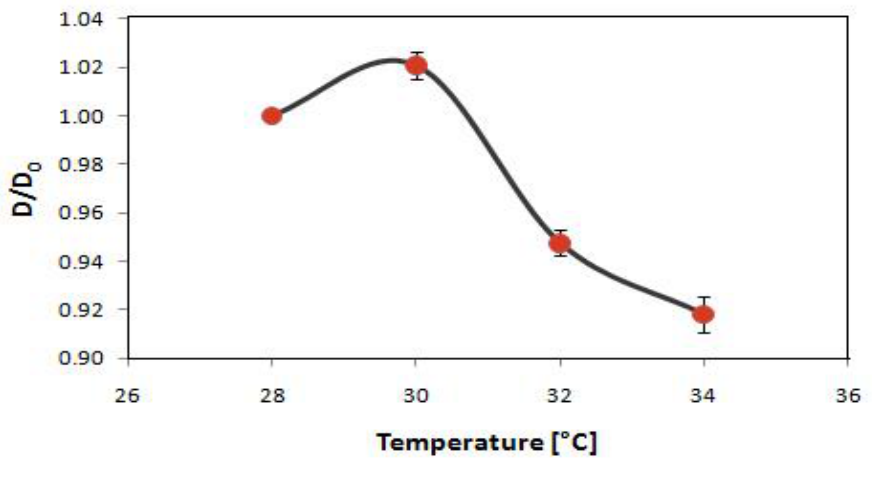
Figure 8. The dependence of normalized average diameter of the composite nanoparticles on temperature. The initial diameter at 28 °C for each individual batch is used for normalization. The error bars show standard deviations of particles made in three different batches and the curve smoothly connects the data